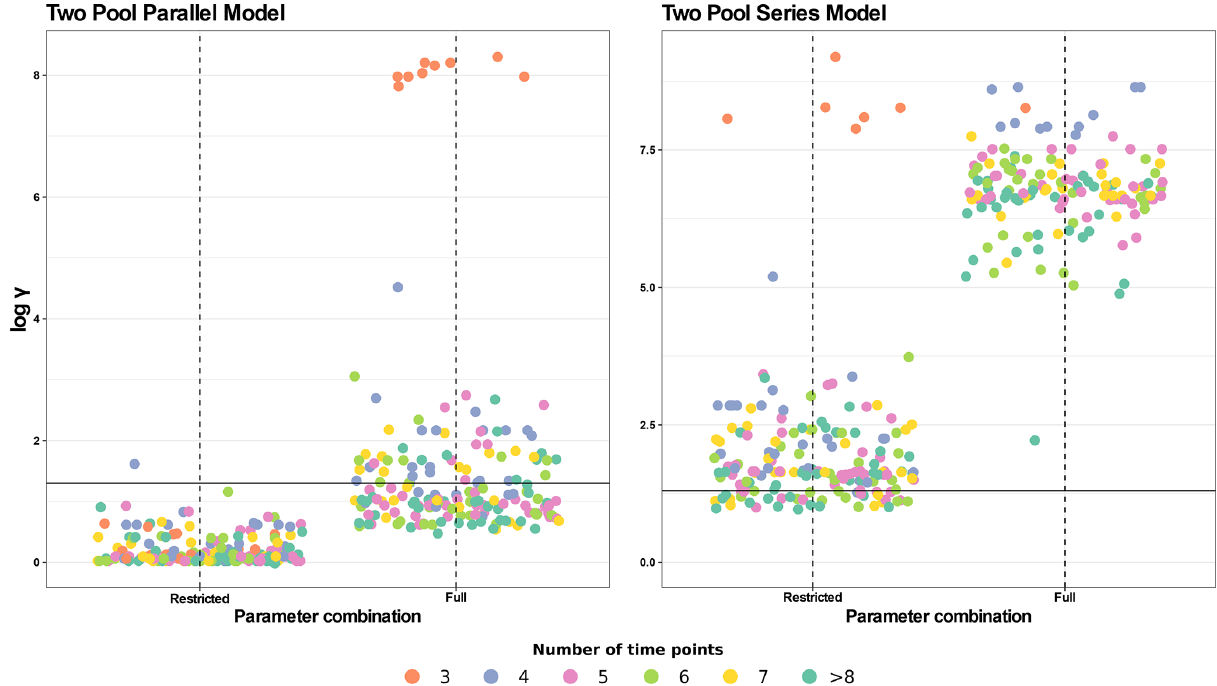
Figure 6. Collinearity index ( γ ) comparison for four different model structures using the entire database. The full parameter combination includes k 1 , k 2 , p 1 , and a 12 (the latter only for the series model). The restricted parameter combination excludes p 1 . γ values were log 10 transformed and horizontal lines at log 10 (20) denote the maximum value of γ for a model to be considered identifiable. Infinite γ values were not plotted. Each panel shows data for a different model structure. Each point represents γ for a model structure fitted for a specific dataset with different parameter combinations ( n = 184, for each model structure). The color scale for data points shows the number of data points in each dataset (i.e., the number of sampling dates plus the initial date). Values with > 8 time points were grouped for easier